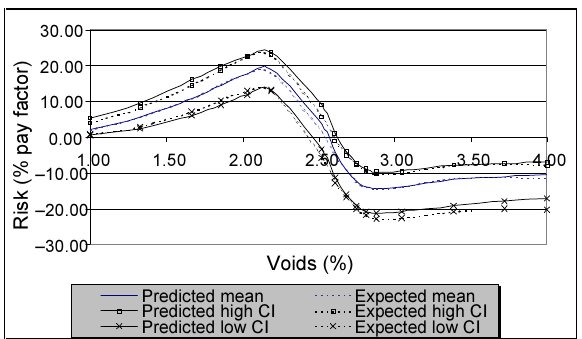
much accuracy, then the chosen network would be consi- dered as a good surrogate simulation model.